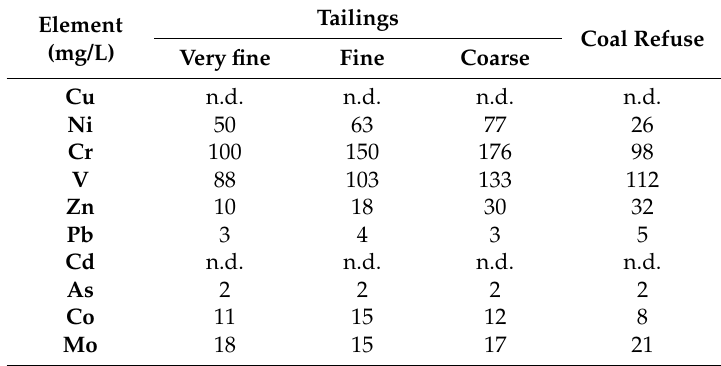
Table 6. Chemical analysis of minor elements in the raw tailings samples (n.d. = not detected). Tailings Element Coal Refuse (mg/L) Very fine Fine Coarse Cu n.d. n.d. n.d. n.d. Ni 50 63 77 26 Cr 100 150 176 98 V 88 103 133 112 Zn 30 32 Pb Cd n.d. n.d. n.d. n.d.